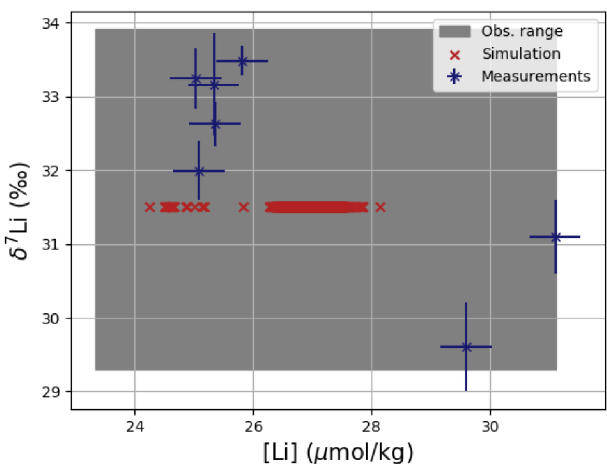
Figure 5. Comparison between measured and simulated concen- trations and isotopic composition of dissolved Li in seawater. The displayed data points are measurements of Sr concentrations and isotope ratios on the same samples (Hall, 2002), while the gray box also indicates the range of concentrations and isotopic compositions that were measured separately (Angino and Billings, 1966; Fabri- cand et al., 1967; Chan, 1987; Chan and Edmond, 1988; You and Chan, 1996; Moriguti and Nakamura, 1998; Tomascak et al., 1999; James and Palmer, 2000; Košler et al., 2001; Nishio and Nakai, 2002; Bryant et al., 2003; Pistiner and Henderson, 2003; Millot et al., 2004; Choi et al., 2010; Pogge von Strandmann et al., 2010; Lin et al., 2016; Henchiri et al., 2016; Phan et al., 2016; Weynell et al., 2017; Fries et al., 2019; Gou et al., 2019; Hindshaw et al., 2019; Murphy et al., 2019; Pogge von Strandmann et al., 2019b). Observations and model results are salinity-normalized.